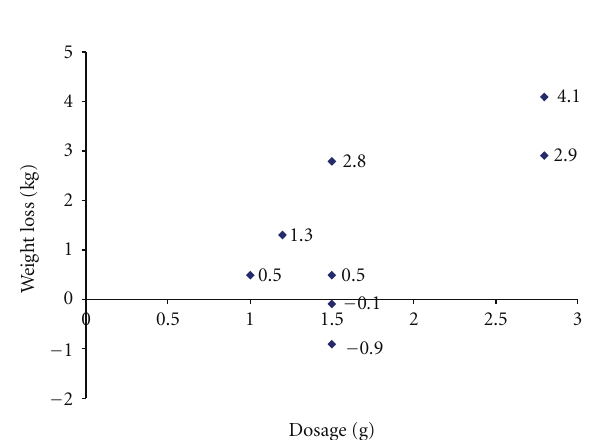
Figure 4: E ff ect of dosage of HCA on body weight. The dosages from included RCTs did not produce a linear e ff ect on body